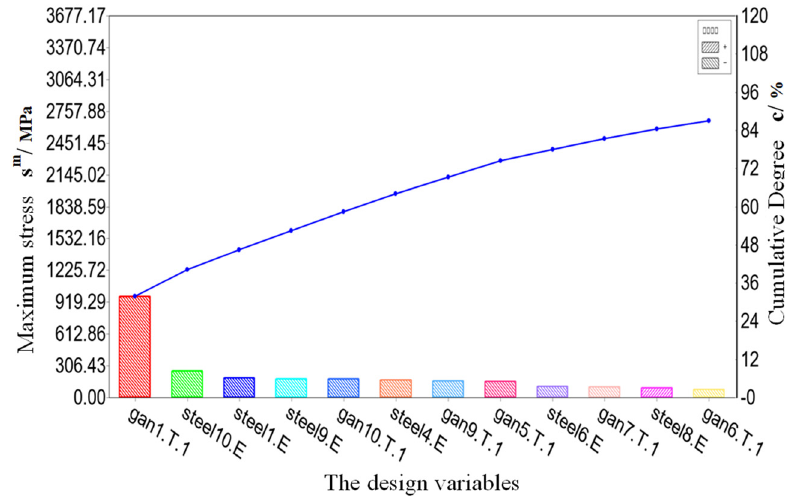
Figure 14: The result of the sensitivity analysis with stress parameters under wind and snow conditions.